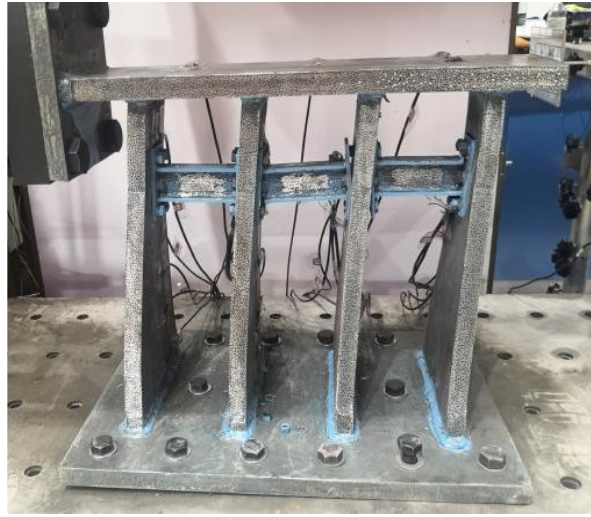
Figure 8. Specimen deformation Δ = 80 mm.